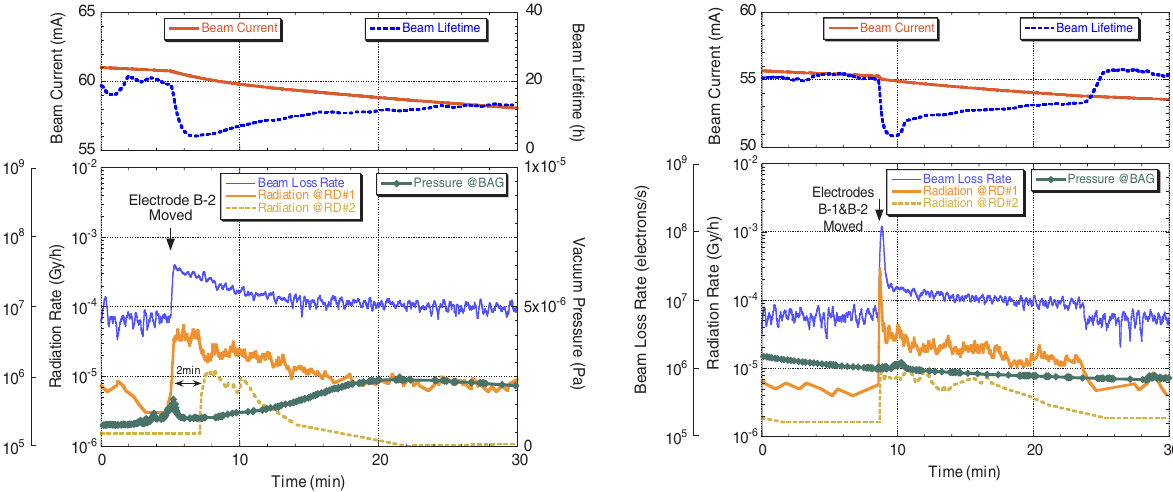
FIG. 10. (Color) Experimental data recorded when the beam lifetime decreased because of the mechanical movement of electrodes B. Appearance of a luminous body was observed concurrently with the decrease in the beam lifetime using video cameras.